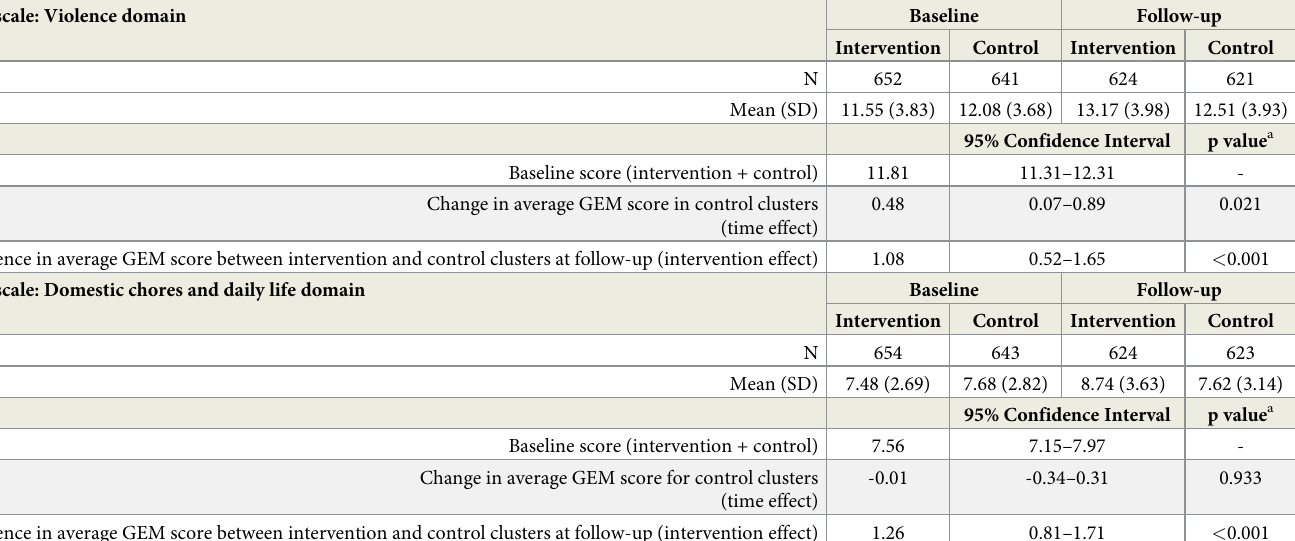
Table 7. Gender norms. GEM scale: Violence